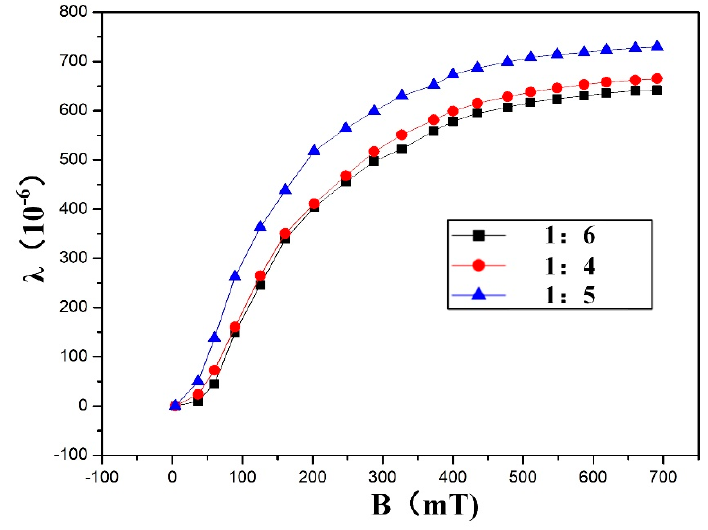
Figure 8. The influence of the proportion of TD powder on magnetostrictive composites.